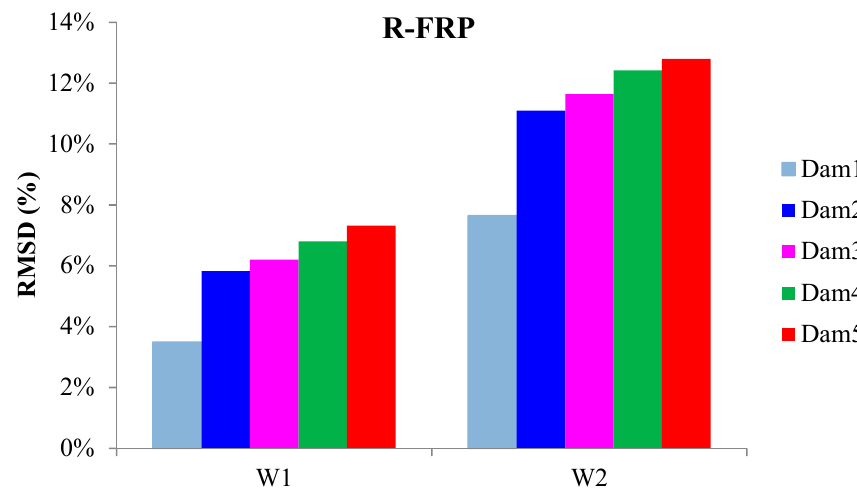
Figure 21. RMSD index values of PTZs mounted on the C-FRP rope of R-FRP.